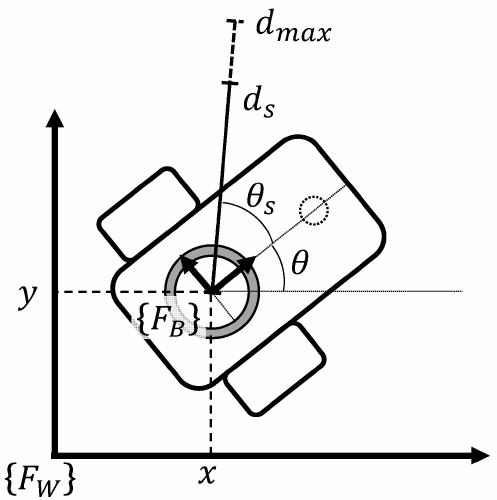
Figure 2. Object detection for differential drive robot